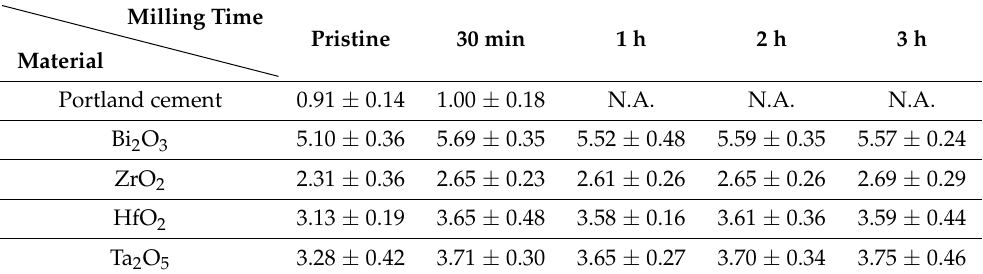
Figure 2. Variation of ( a ) grain size and ( b ) radiopacity for as ‐ milled oxide powder as a function of milling time. Table 1. Radiopacities of cements prepared using oxide radiopacifier after ball milling treatment.